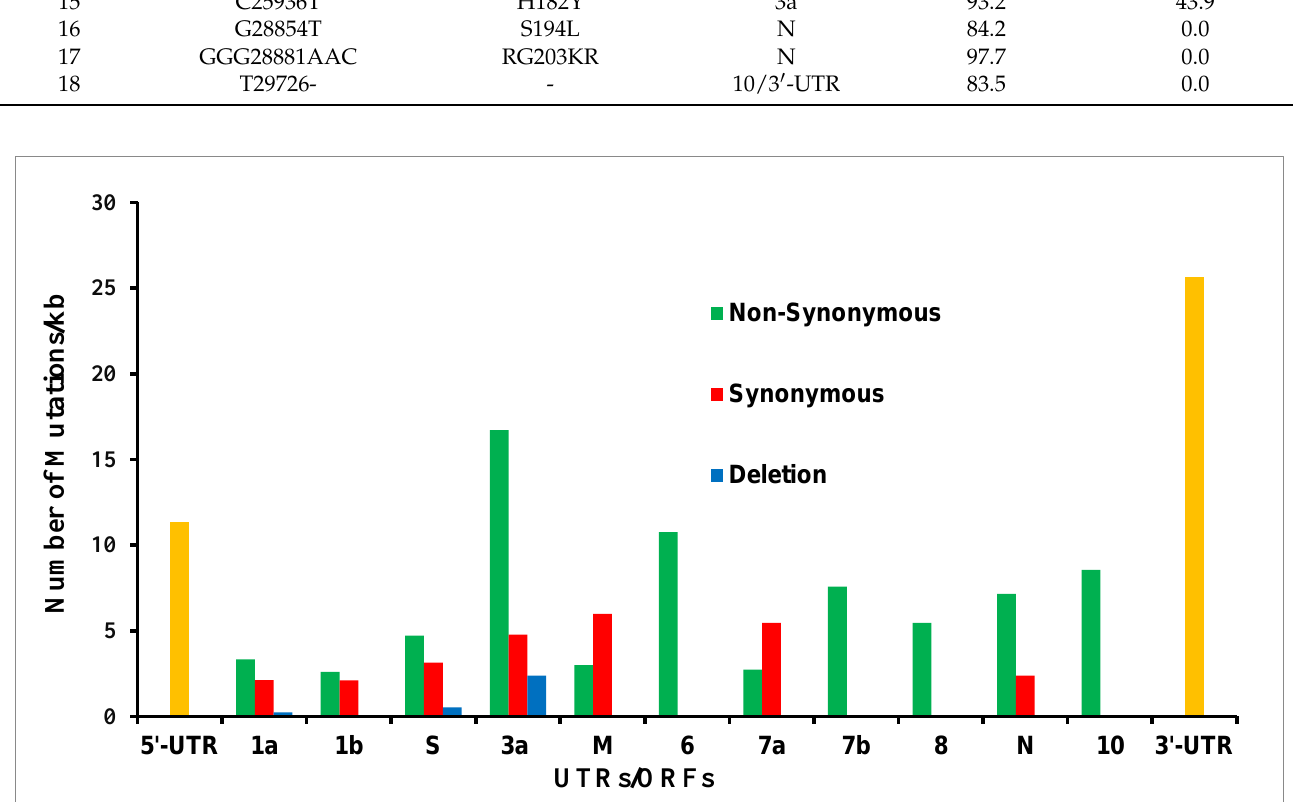
Figure 3. The synonymous, non-synonymous, and deletion mutations at the amino acid level in the mink-derived SARS-CoV-2 genome from Netherlands and Denmark samples. The UTRs (untrans- lated regions) are shown in yellow.